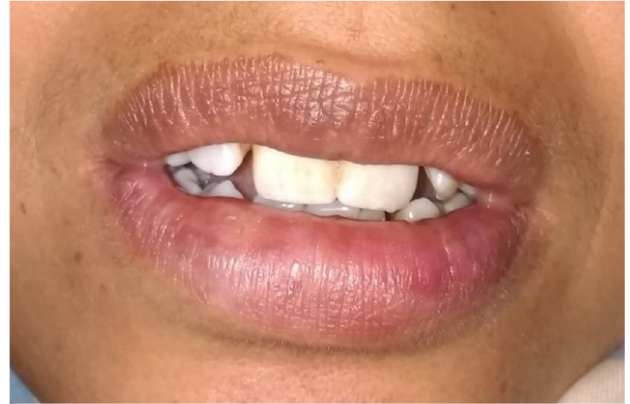
Fig. 6. Entirely resolved within seven months.